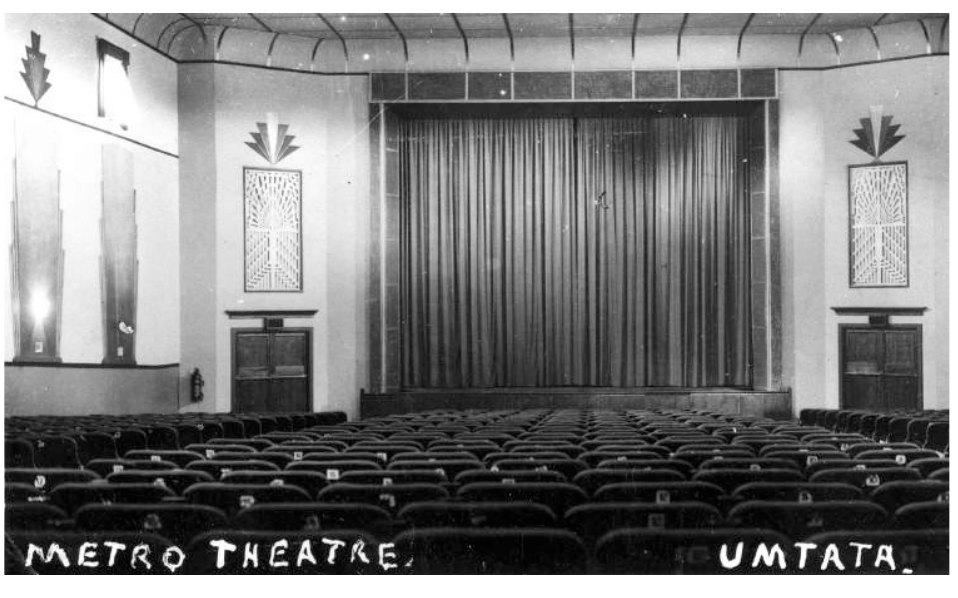
Metro Theatre, Umtata, South Africa, c. 1930 . Archival photograph (photo: courtesy Penny Siopis and Stevenson Gallery, Cape